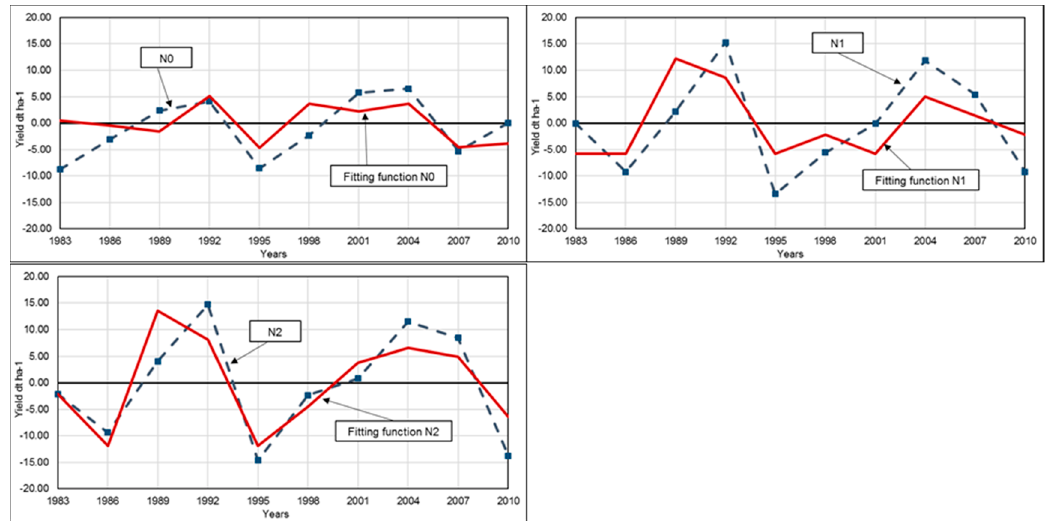
Figure 4. Measured and predicted (Table 3) residuals with yearly predictors for the different fertilization levels. N0, unfertilized plots; N1, low fertilized plots; N2, high fertilized plots.